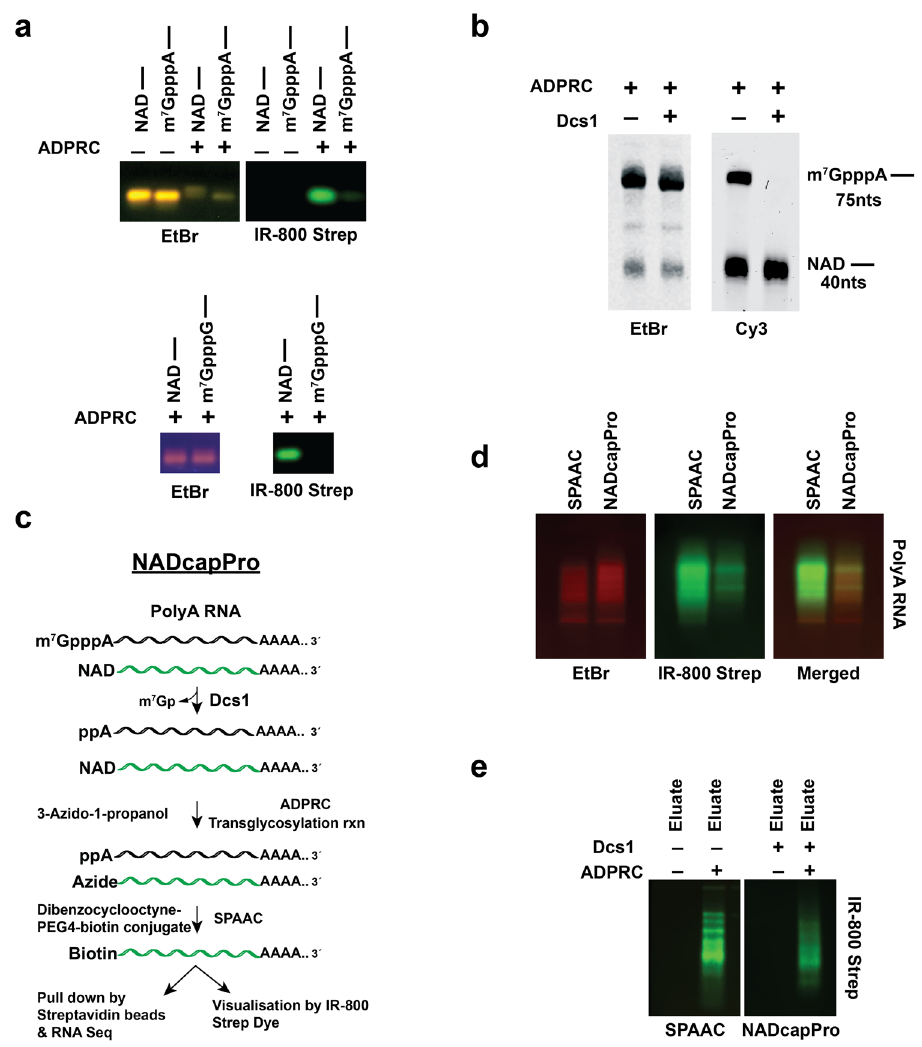
Fig. 2 ADPRC cross-reactivity with m 7 GpppA capped RNAs and NADcapPro as a superior method to resolve the inherent limitations of previous methods. a Ten picomoles of 40nts in vitro transcribed NAD-, m 7 GpppA- and m 7 GpppG-capped RNA were subjected to the SPAAC reaction and visualized using IRDye ® 800CW. Detection of biotinylated RNA analyzed by SPAAC revealed residual activity only on m 7 GpppA-capped RNA. b In vitro transcribed m 7 GpppA-RNA (75nts) with and without Dcs1 and 40nts of NAD-capped RNA were mixed at molar ratios of (50:1) in a SPAAC reaction. The RNAs were visualized directly in the gel. ADPRC exhibited a noticeable activity towards m 7 GpppA capped RNA in the absence of Dcs1 treatment. Treatment of the RNA mixture with Dcs1 explicitly abolished the reactivity of the APRC towards the m 7 GpppA-capped RNA without compromising the detection of NAD-RNA. c Schematic illustration of NADcapPro protocol used in the present study. d Comparison of the SPAAC and NADcapPro reactions using endogenous polyA + RNA isolated from yeast were resolved by agarose gel electrophoresis and visualized using IRDye ® 800CW. A substantial reduction in NAD-RNA signal is apparent in the NADcapPro lanes compared to the SPAAC lanes, consistent with the selective removal of m 7 G-capped RNA detection. e PolyA + RNA (15 µ g) was subjected to SPAAC and NADcapPro. The af fi nity-puri fi ed biotinylated RNA corresponding to NAD-capped RNA was eluted from streptavidin beads and visualized using IRDye ® 800CW as in ( d